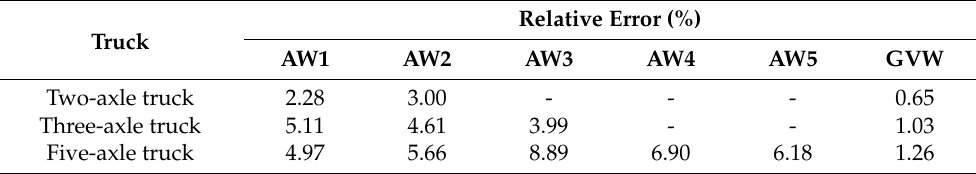
Table 4. Identification error considering lateral loading